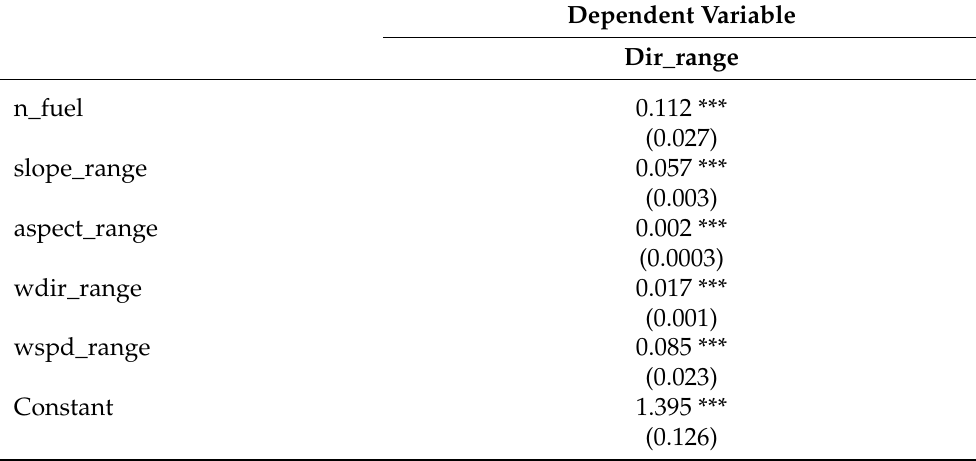
Table 3. Generalized Linear Model Summary for Modeling the Range of Forecast Propagation Direction Values (dir_range) from the Range of Fuel Models (n_fuel), Terrain Slope (slope_range), Aspect (aspect_range), 10 m Height Wind Direction (wdir_range), and 10 m Height Wind Speed (wspd_range). Each variable is shown with its respective regression coefficient, statistical significance (asterisks), and root mean squared error (RMSE, in